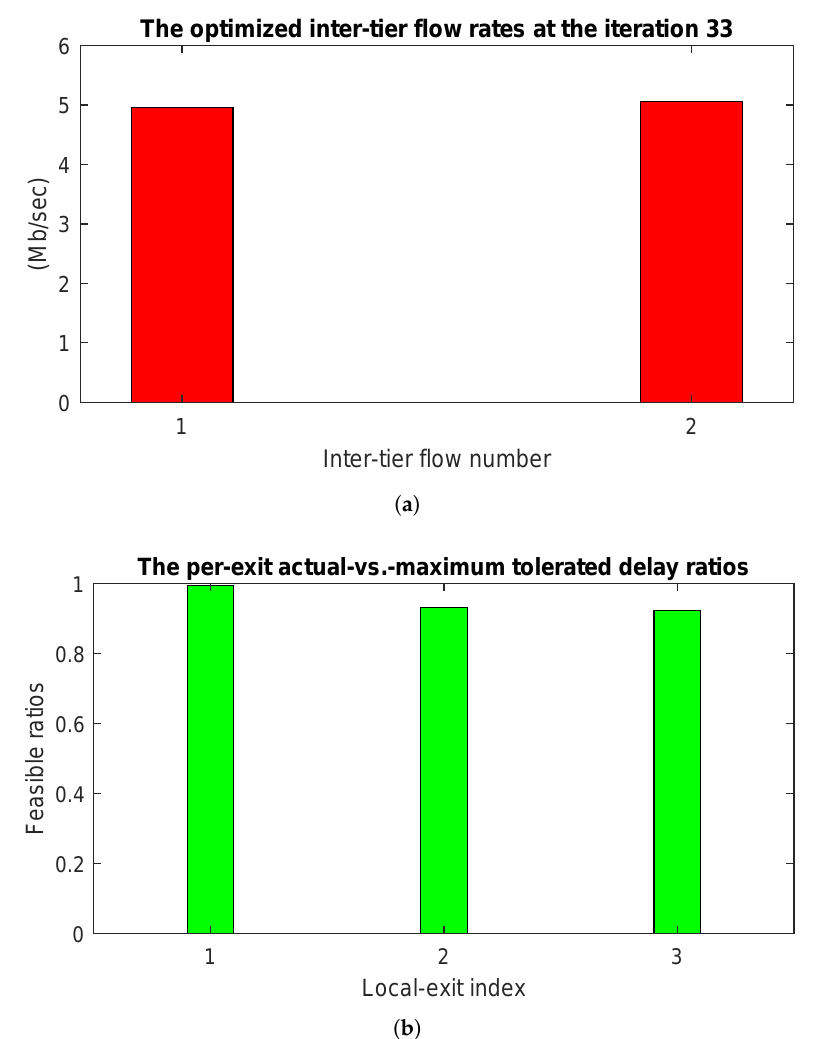
Figure 12. Values under topology T 1 of the: ( a ) optimized transmission rates and ( b ) actual-vs.- maximum tolerated delay ratios. By design, the returned optimized resource allocation is feasible if all these ratios are not larger than the